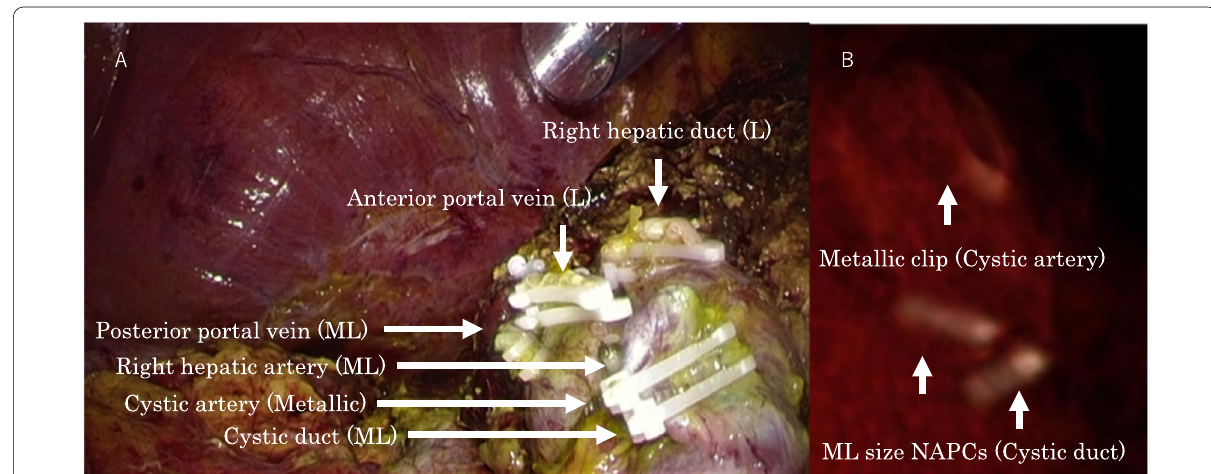
Fig. 2 Intraoperative findings of a laparoscopic right hemihepatectomy and CT imaging of the duodenal bulb. A A laparoscopic right hemihepatectomy had been performed for an intrahepatic bile duct cystadenocarcinoma. Medium-large (ML) NAPCs were placed at the cystic duct, right hepatic artery, and the posterior branch of the portal vein. Large NAPCs were placed at the right hepatic duct and at the anterior and posterior branches of the portal vein. A metal clip was placed at the cystic artery. B Reconstructed CT imaging showed two ML NAPCs on the duodenal bulb and one metal clip